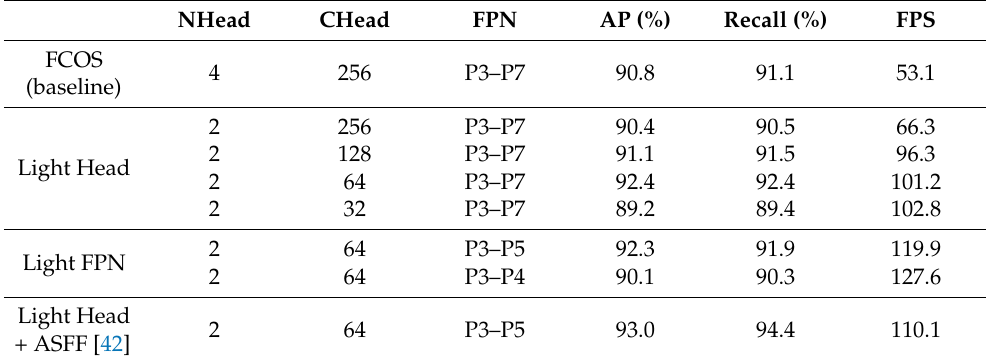
Table 1. Ablation study on the light detection head and the light Feature Pyramid Network (FPN) in